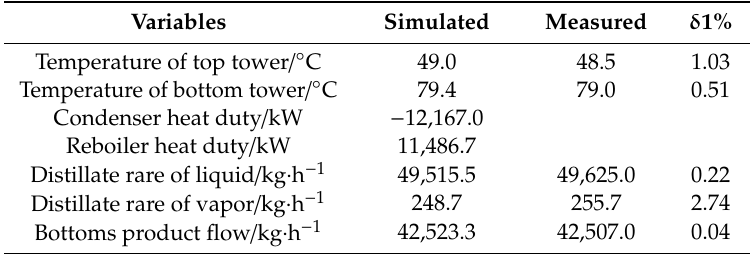
Table 6. Comparison of the simulation results of Example